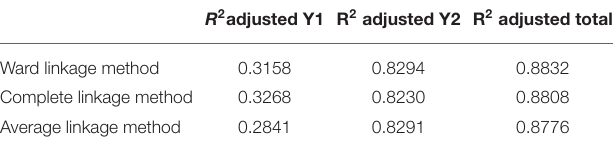
TABLE 7 | Score R 2 adjusted on each model.